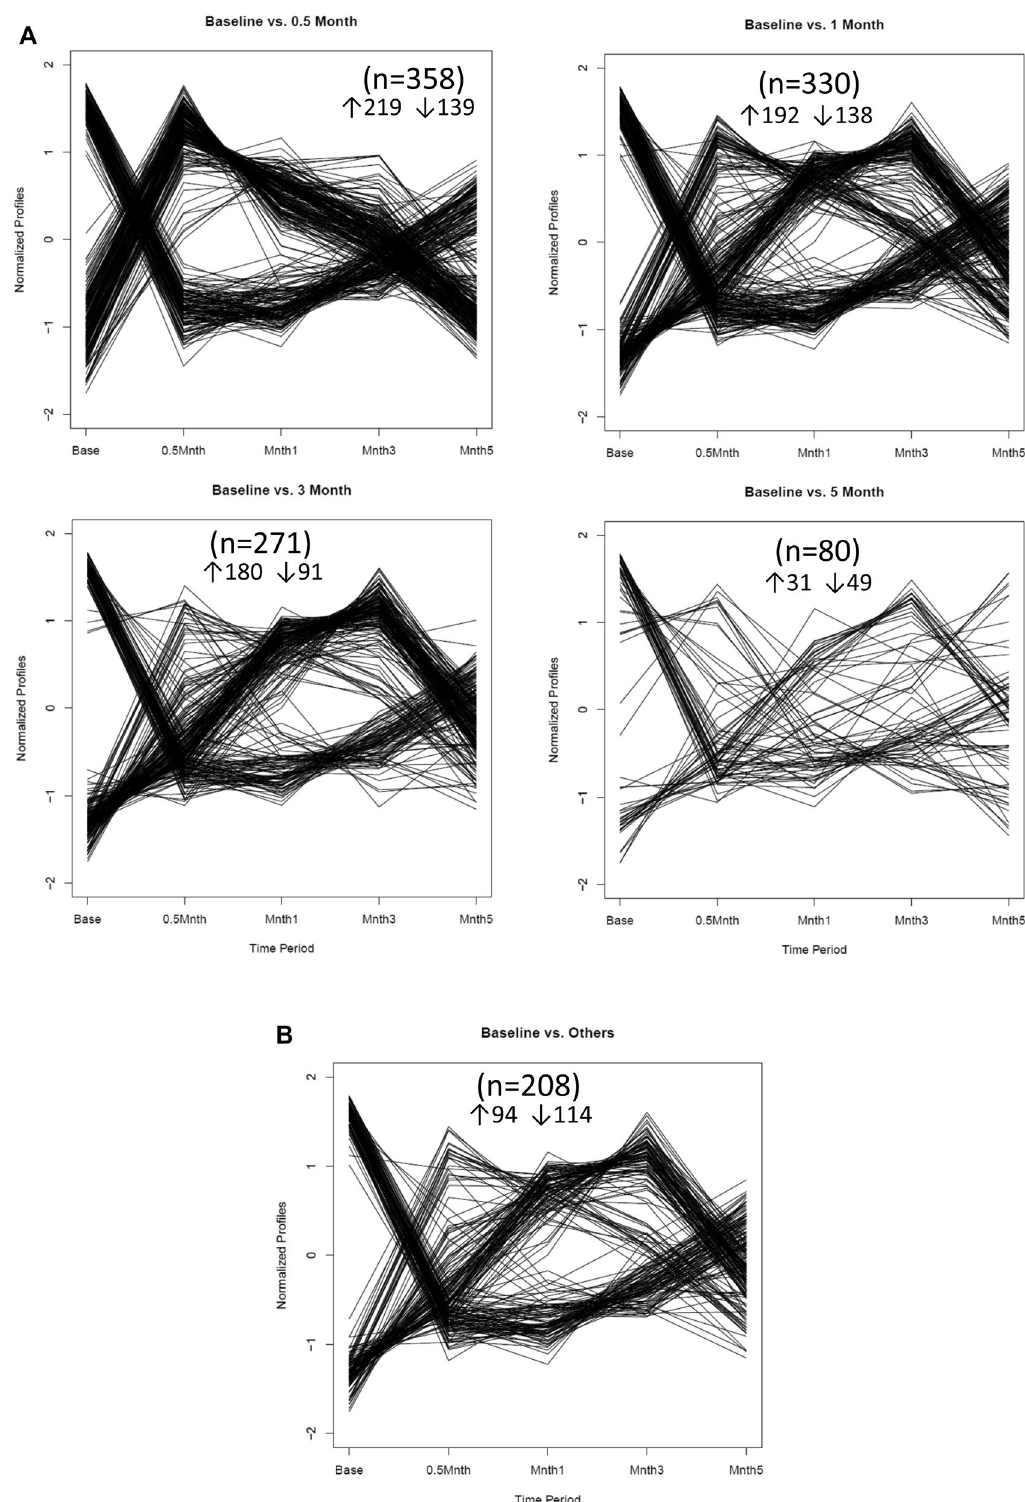
Figure 3. ( A ) Patterns of gene expression with disease and resolution compared to baseline/health. ( B ) Patterns of gene expression in baseline/health versus all other time points. ( C ) Patterns of gene expression with disease and resolution compared all other time points in the model. Numbers in parentheses denote number of genes within the particular patterns, and whether the patterns denoted up ( ↑ ) or down-regulation ( ↓ ) of the gene